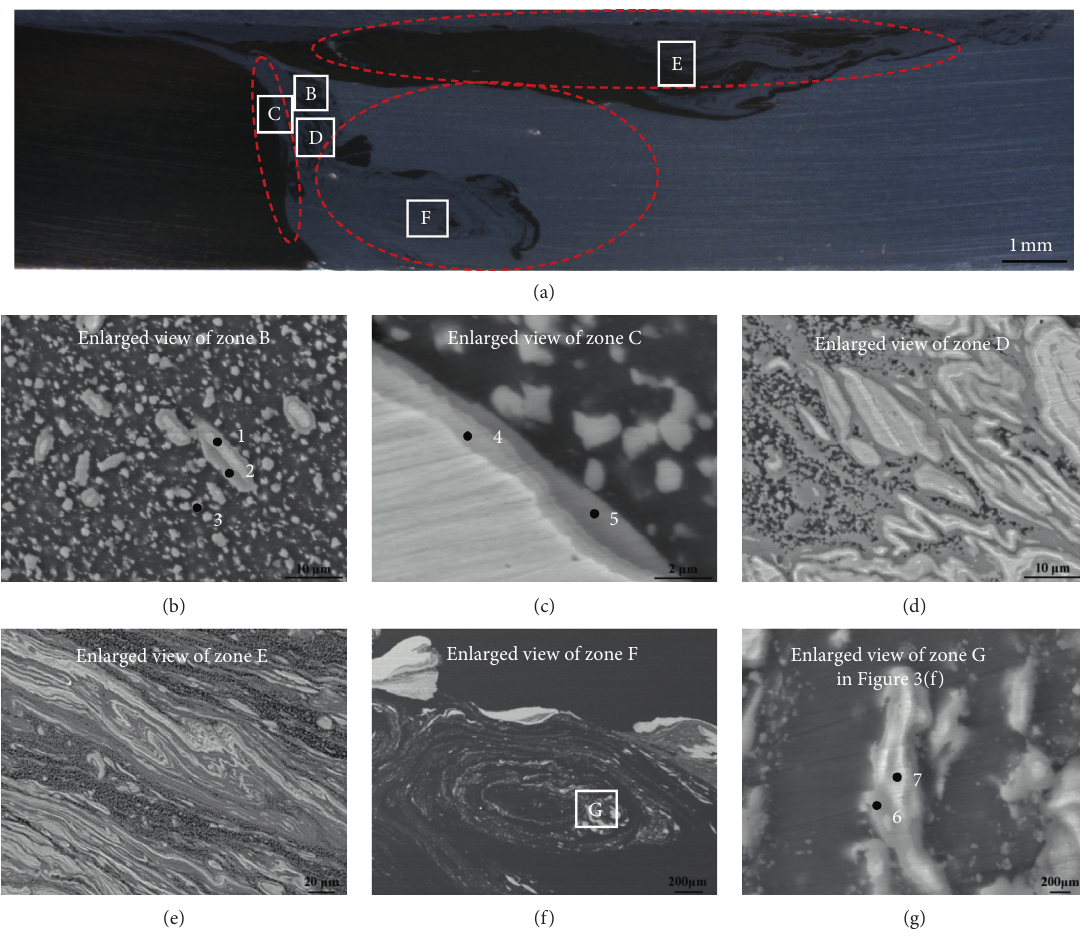
Figure 3: The cross-sectional morphologies and the regional characteristics of the Al-Cu FSW joints. Table 2: EDS point analysis results of location in Figure